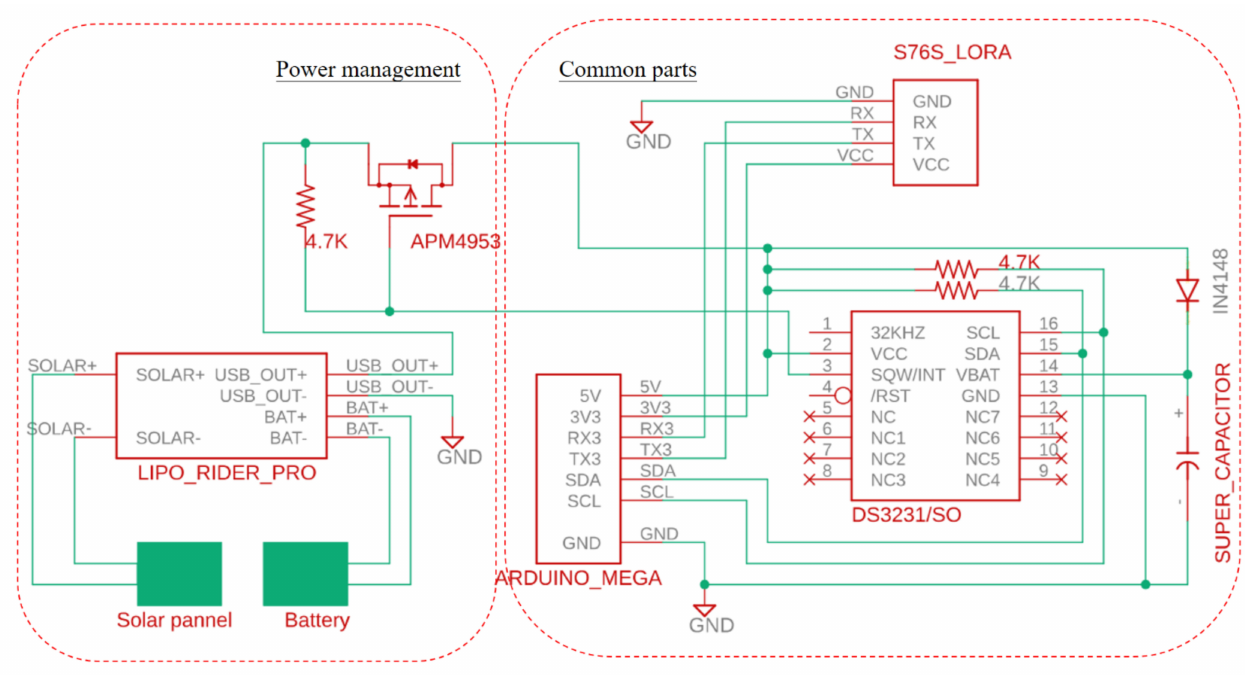
Figure 2. A partial schematic for the common parts ( right ) and power management ( left